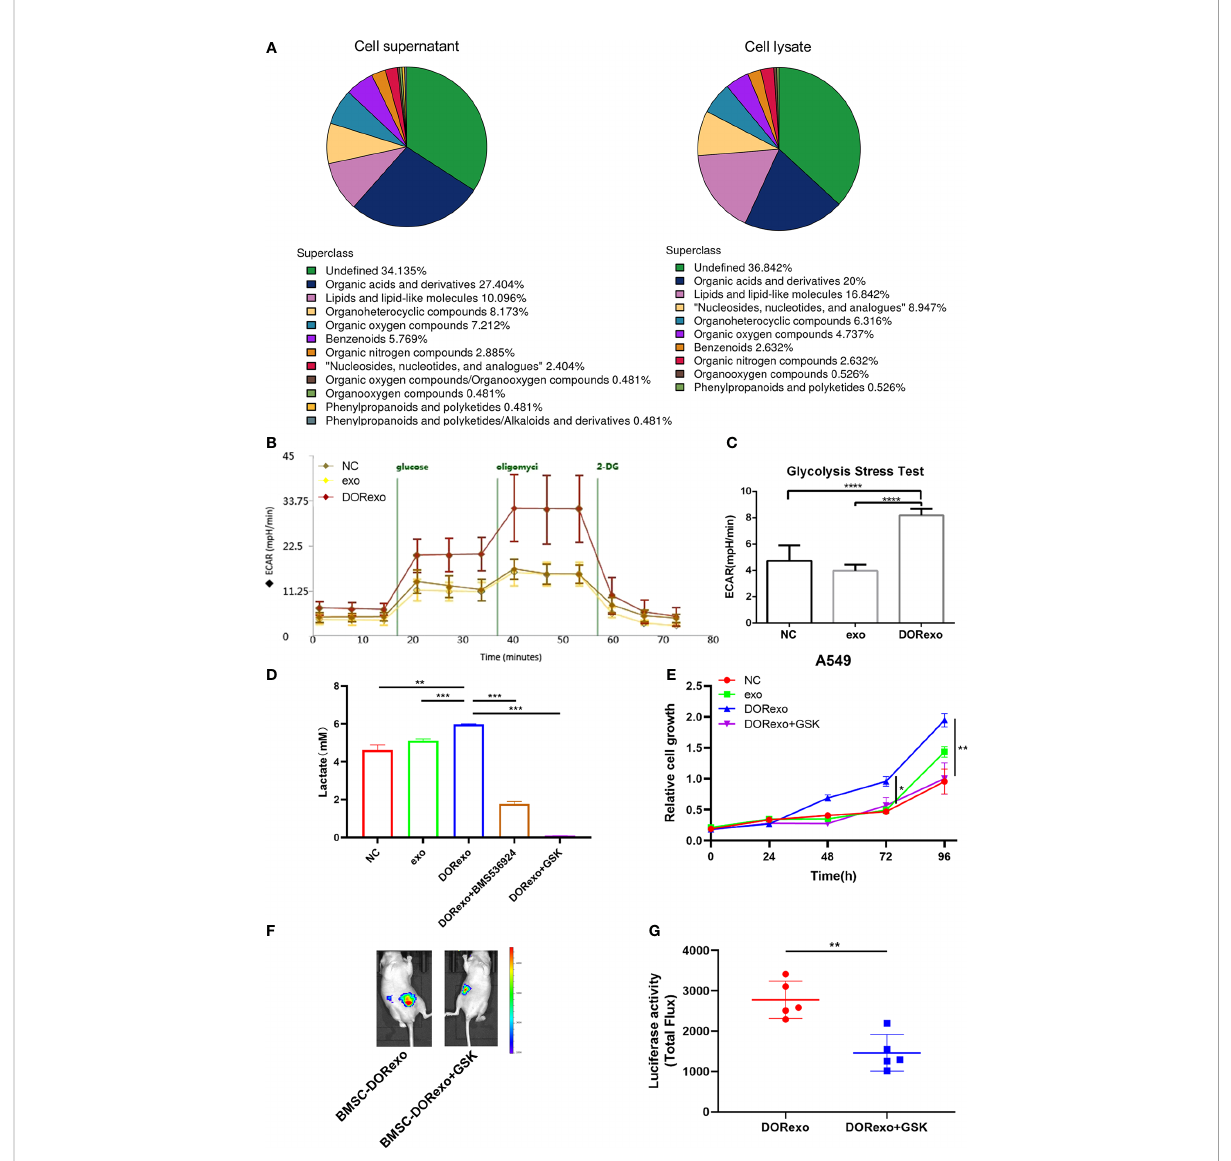
FIGURE 4 Exosomes promote glycolysis of BMSCs to increase lactic acid production and promote cancer cell growth. Glycolytic stress test was performed to assess the extracellular acidi fi cation rates (glycolysis) in BMSCs. (A) Metabolite classi fi cation in cell lysates and cell supernatants derived from DORexo-treated BMSCs. (B) Kinetic ECAR response of exo-treated BMSCs and DORexo-treated BMSCs to glucose, oligomycin, and 2-DG. Each point represents mean ± SD, n = 16. (C) Calculated glycolytic fl ux, glycolytic capacity. (D) Expression of lactic acid in cell supernatants; BMSCs treated with or without GSK were cocultured with A549; BMS-536924, IGF-1R inhibitor; GSK2837808A (GSK), lactate dehydrogenase A inhibitor. (E) Proliferative capacity of A549 cocultured with BMSCs treated with different exosomes and GSK. (F) Animal imaging fl uorescence images on 63 days after A549-luciferase cell injection. BMSCs that were incubated with exosomes were injected into the bone marrow cavity, and A549- luciferase cells were injected into the bone marrow cavity 3 days later. The growth and metastasis A549 were evaluated by bioluminescence. Lactate dehydrogenase A inhibitor GSK2837808A (GSK) was applied in the experiment. All mice were intramedullary injected with luciferase- labeled A549 cells. MSC-DORexo, mice with injection of DORexo-treated BMSCs; MSC-DORexo+GSK, mice with injection of DORexo-treated BMSCs and GSK. (G) The activities of luciferase were shown. *P < 0.05; **P < 0.01; ***P < 0.001; ****P <